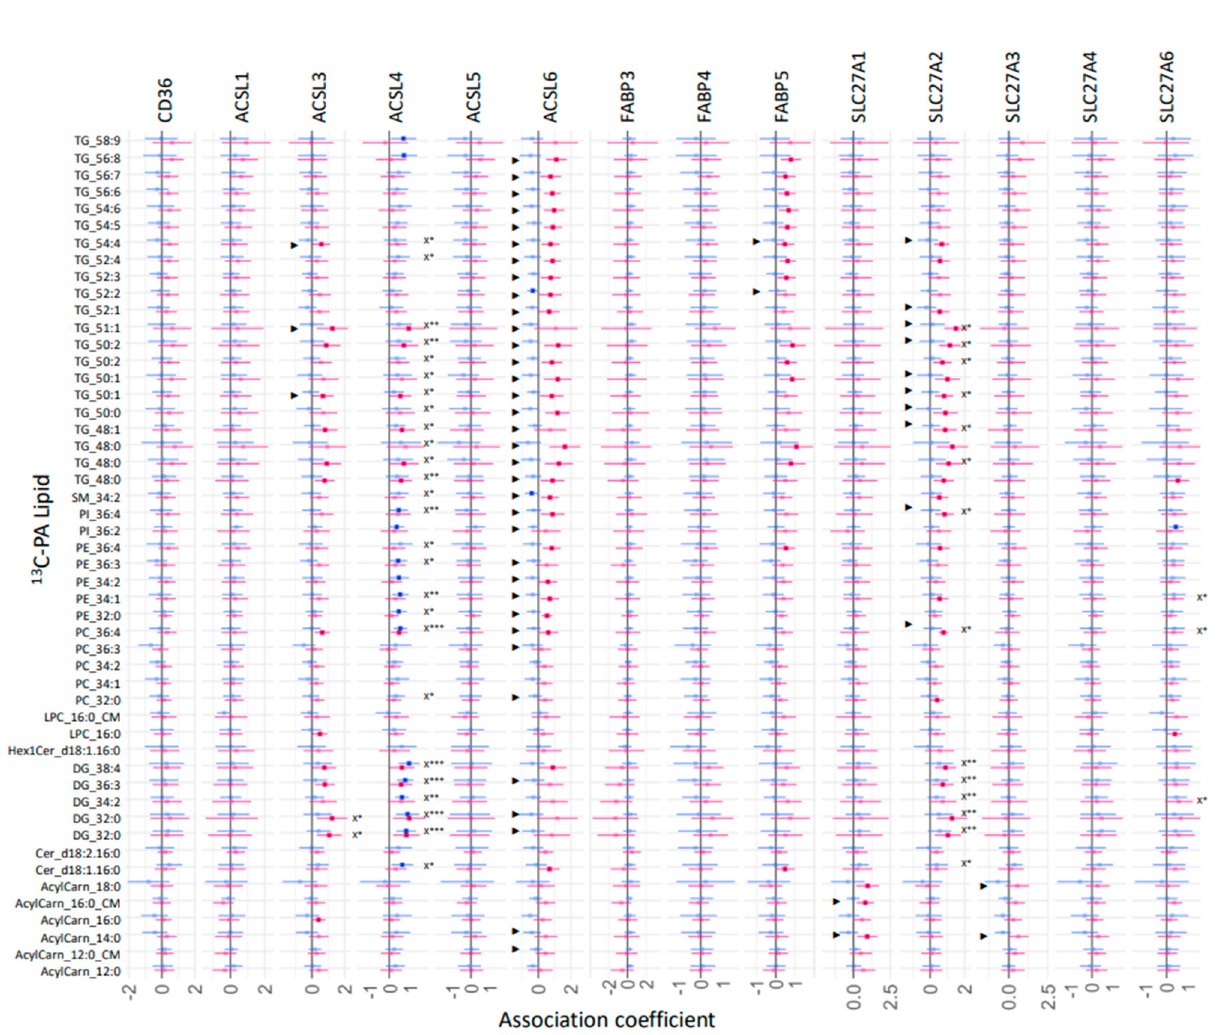
Figure 8. Sex-stratified associations between the amount of 13 C-PA lipids (outcome) with relative mRNA abundance after 48 h of culture. Lipid amount was log2 transformed, mRNA abundance was log-2 transformed and z-scored. Linear regression with males and females combined (not shown) with significance p < 0.05 is indicated by X*, whilst significance p < 0.01 or 0.001 is indicated by X** and X***. Interaction between sex and maternal glycemia on lipid amount were then investigated with significant interactions p <0.05 denoted by “ ► ”. Linear regression was then run separately for males and females. Forest plots show association coefficient and 95% confidence intervals for males (blue) and females (red) with significance ( p < 0.05 shown by dark-colored filled circles. The Benjamini–Hochberg method was used to correct for multiple testing.